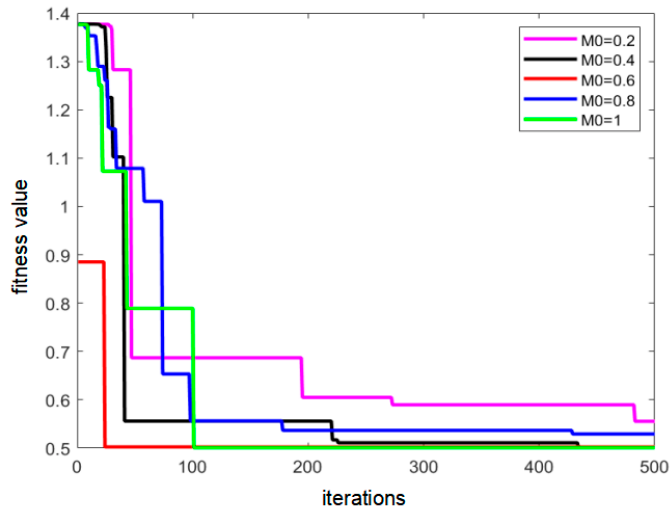
Figure 7. Schematic of algorithm performance under different M 0 values.